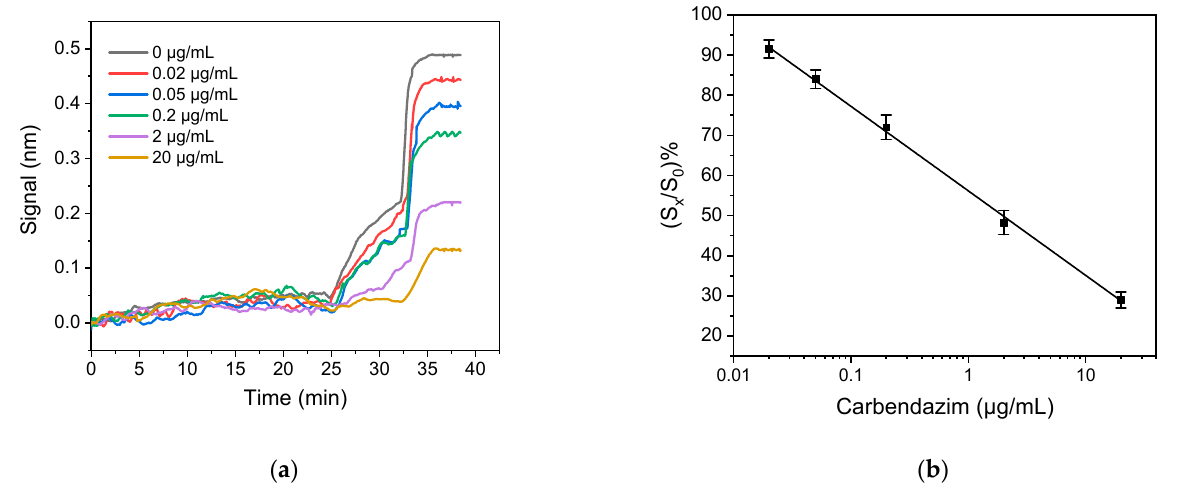
Figure 4. ( a ) Real-time responses obtained from biochips functionalized with 500 μ g/mL benzimidazole conjugate upon running sequentially: assay buffer; a 1:1 v/v mixture of carbendazim standards (0 – 20,000 ng/mL) prepared in assay buffer with a 2 μ g/mL anti-carbendazim antibody solution in the same buffer; a 1:200 diluted solution of biotinylated secondary antibody in assay buffer; a 10 μ g/mL streptavidin solution. ( b ) Typical calibration plot for carbendazim. Each point represents the mean value of 4 runs ± SD.